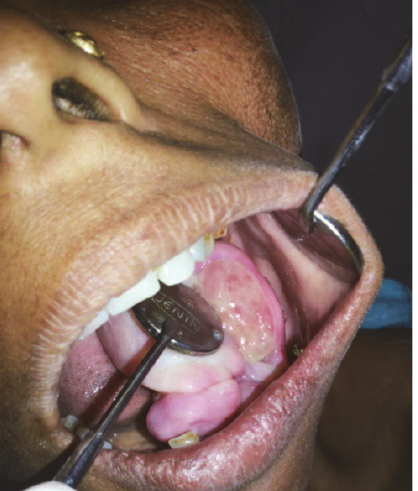
Figure 3: Intraoral preoperative lesion.